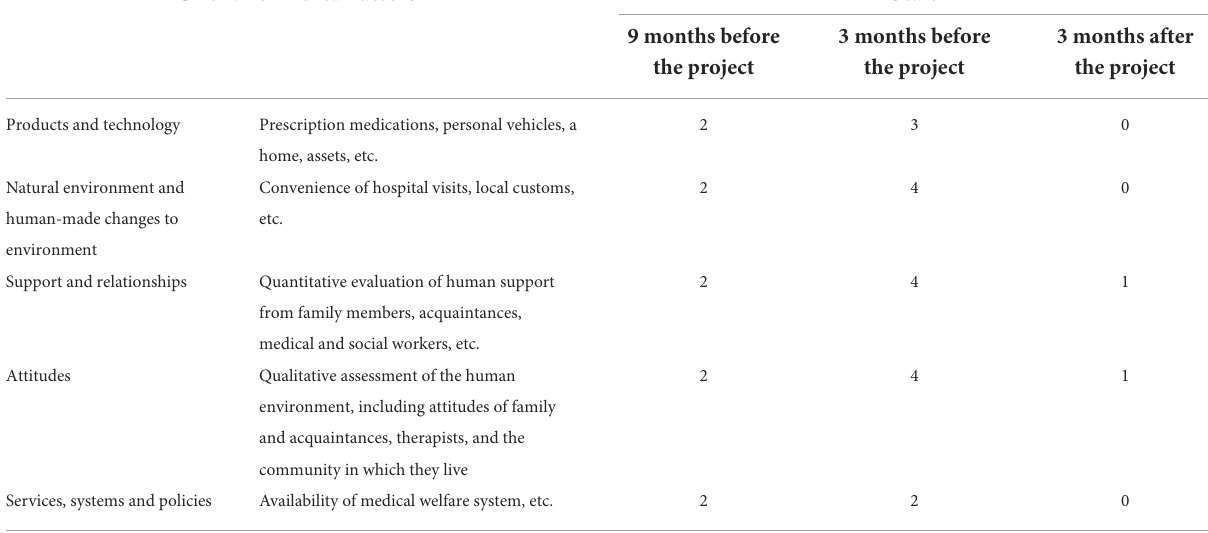
TABLE 2 Change of Scale on the ICF environmental